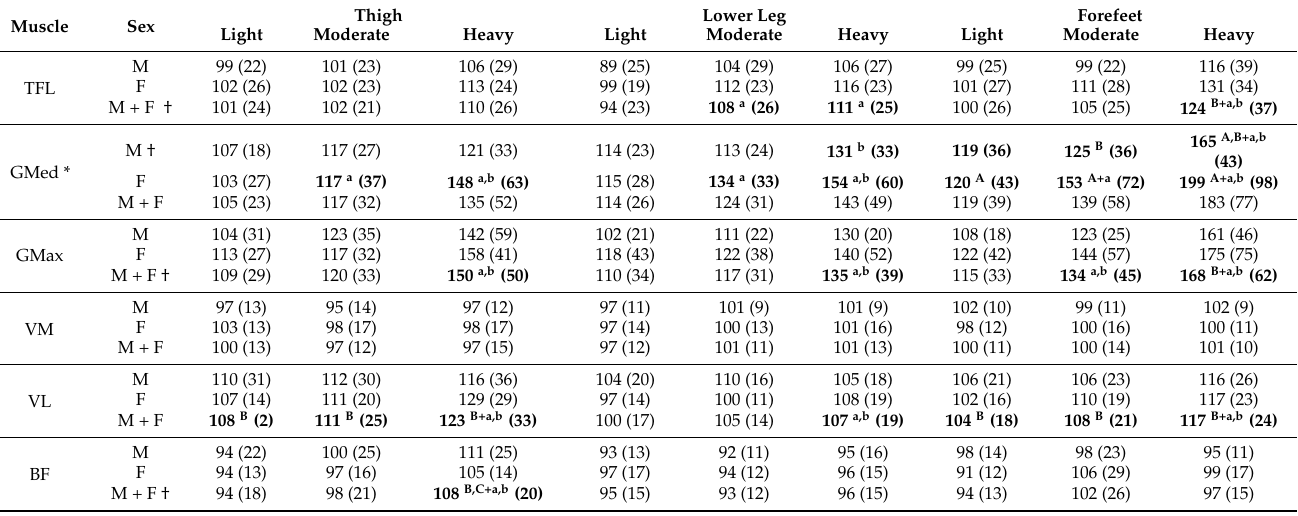
Table 2. Sample mean (standard deviation) of vastus medialis (VM), vastus lateralis (VL), biceps femoris (BF), gluteus maximus (GMAX), gluteus medius (GMED) for men (M) and women (W), and tensor fascia lata (TFL) during squatting for all combinations of band stiffness (light, moderate, and heavy) and band position (thigh, lower leg, and forefeet) tested in this study. Myoelectric activity measured for the entire squat cycle was normalized to the myoelectric activity obtained for squatting without elastic resistance and is shown in %. Results are shown for male (M) and female (F) subjects as well as for the total sample pooled across sexes (M + F).